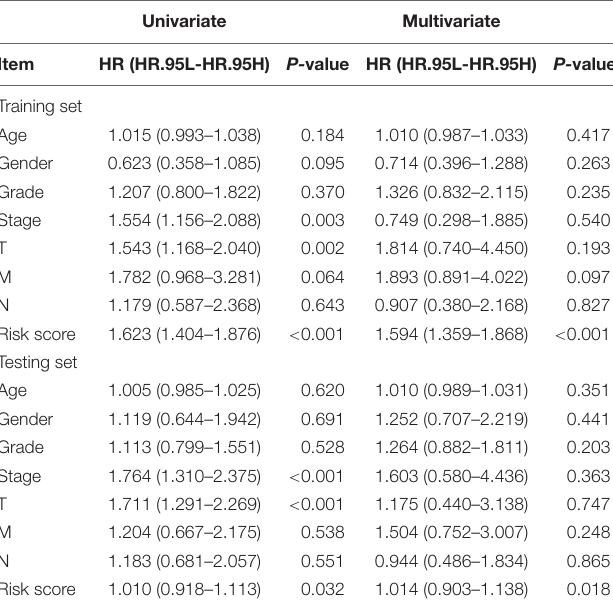
TABLE 2 | The univariate and multivariate Cox analysis to determine the independent prognostic